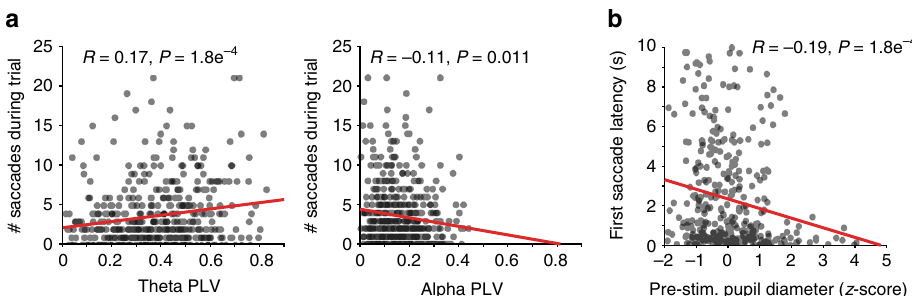
Fig. 7 Thalamo-cortical synchronization and pupil-linked arousal correlate with saccade behavior. a Correlation of thalamo-cortical phase synchronization in the theta (left) and alpha (right) carrier frequency bands and the number of saccades performed during presentation of naturalistic video stimuli. Theta PLV displays a signi fi cant positive correlation with saccadic sampling of stimuli, whereas alpha PLV displays a signi fi cant negative correlation. b Correlation of prestimulus pupil diameter to the latency of the fi rst saccade for subsequent naturalistic video stimulus presentation. Signi fi cant negative correlation illustrates that animals sample visual stimuli more rapidly when they are in a more aroused correlated the prestimulus pupil diameter with the latency of the fi rst saccade for each trial. We found a small but signi fi cant negative correlation between prestimulus pupil diameter and fi rst saccade latency for both image and video stimuli (Fig. 7b, P = 0.0001, R = − 0.19 for video stimuli; for images see Supplementary Fig. 13b, P = 6.39e – 5 , R = − 0.22), indicating that animals sampled more rapidly when incoming sensory input arrived during a state of heightened arousal. Taken together, these results show that ongoing fl uctuations in pupil-linked arousal and